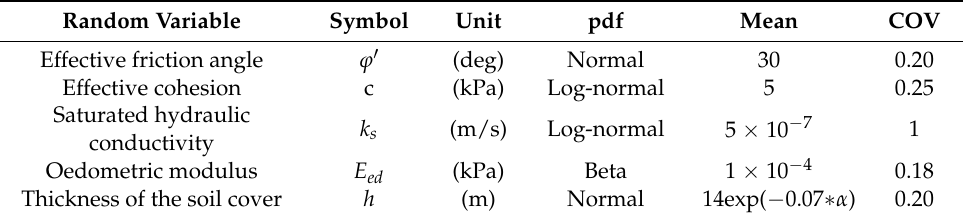
Table 1. Physical and mechanical soil characterization used in the reliability analysis. Random